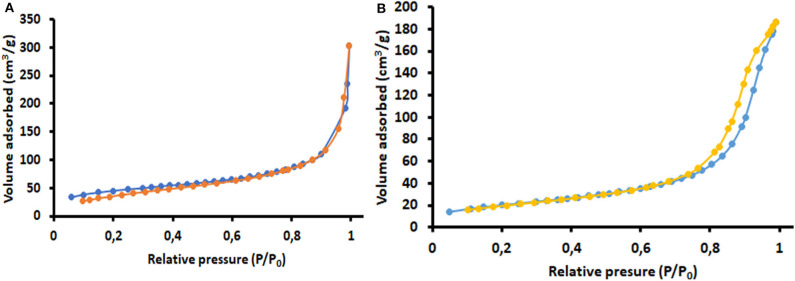
The Nitrogen adsorption-desorption isotherms for (A) P-POP and (B) MP-POP.